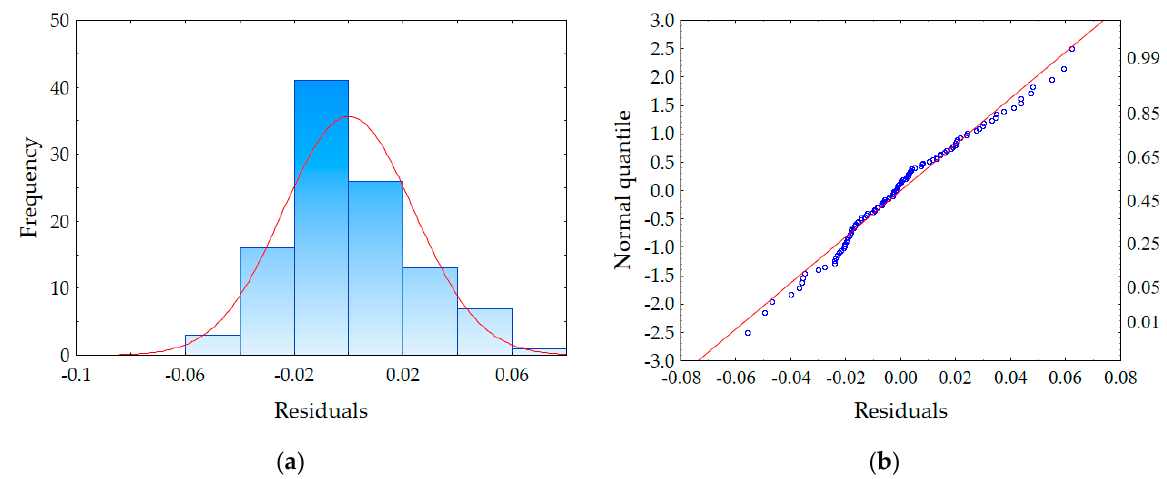
Figure 5. For the best linear-effects model: ( a ) residual frequency; ( b ) residual normal quantile plots.